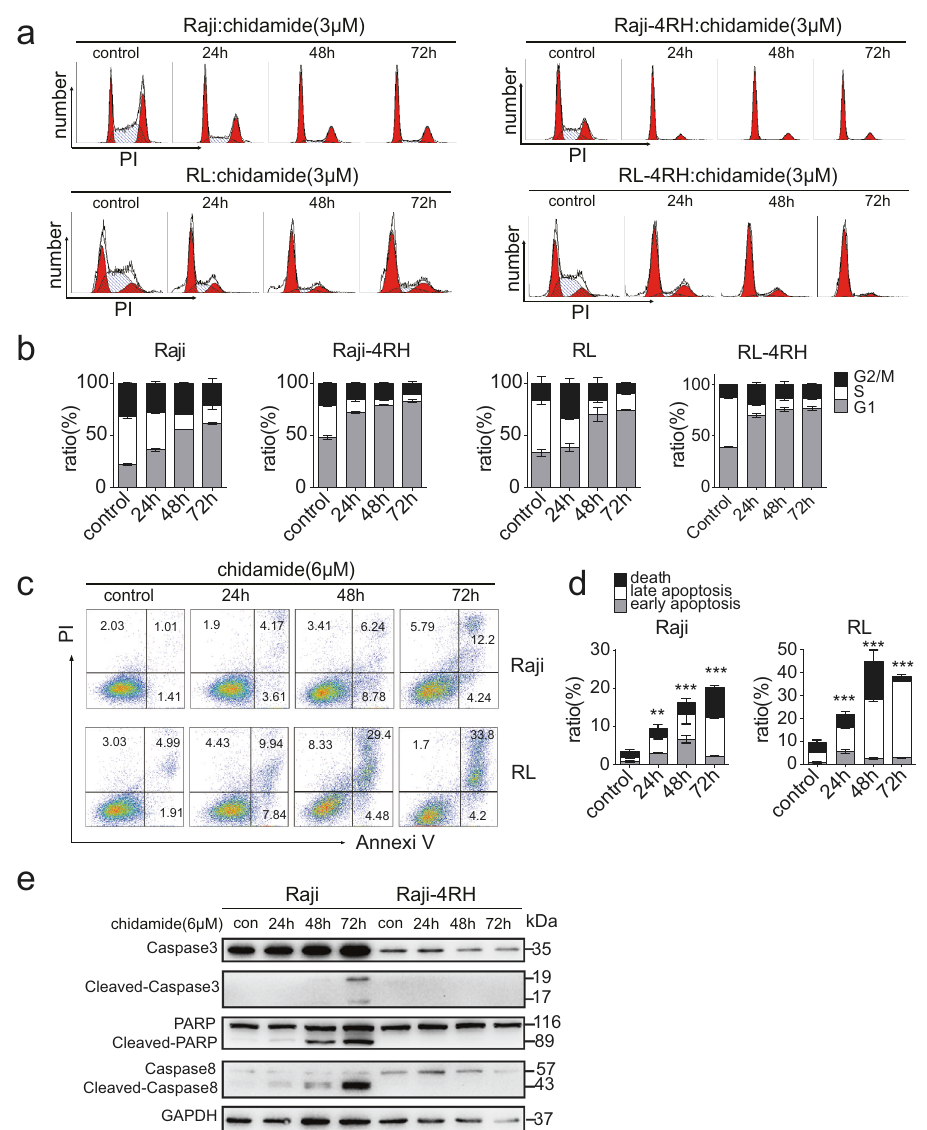
Fig. 2 Chidamide treatment induced cell cycle arrest in both RSCL and RRCL, but triggered cell apoptosis only in RSCL. a , b The cell cycle of RSCL and RRCL treated with chidamide (3 μ M) for 24, 48 or 72 h were examined by fl ow cytometry analyses ( a ). The ratio of G1, S, and G2/M phase were shown in histograph ( b ). c , d Apoptosis of RSCL induced by chidamide (6 μ M) treatment for 24, 48, or 72 h were examined by using fl ow cytometry analysis ( c ). The statistics of early apoptosis, late apoptosis, and cell death were shown in corresponding histograph ( d ). e Changes of apoptosis related proteins were examined by using Western blot analysis in Raji and Raji-4RH treated with chidamide (6 μ M) or DMSO for 24, 48, and 72 h ( N = 3). For all graphs, data are presented as mean ± Raji-4RH and RL-4RH cells (Fig. S2c, S2d). Next, we evaluated the level of apoptosis-related proteins and found that chidamide could not trigger the cleavage of Caspase-3, PARP, and Caspase-8 (Fig. 2e), in Raji-4RH and RL-4RH cells, which was possibly due to the lack of pro- apoptotic proteins in the RRCL [5, 6]. Therefore, these results suggested that the cell cycle arrest but not apoptosis was involved in chidamide-induced cell growth inhibition in RRCL.